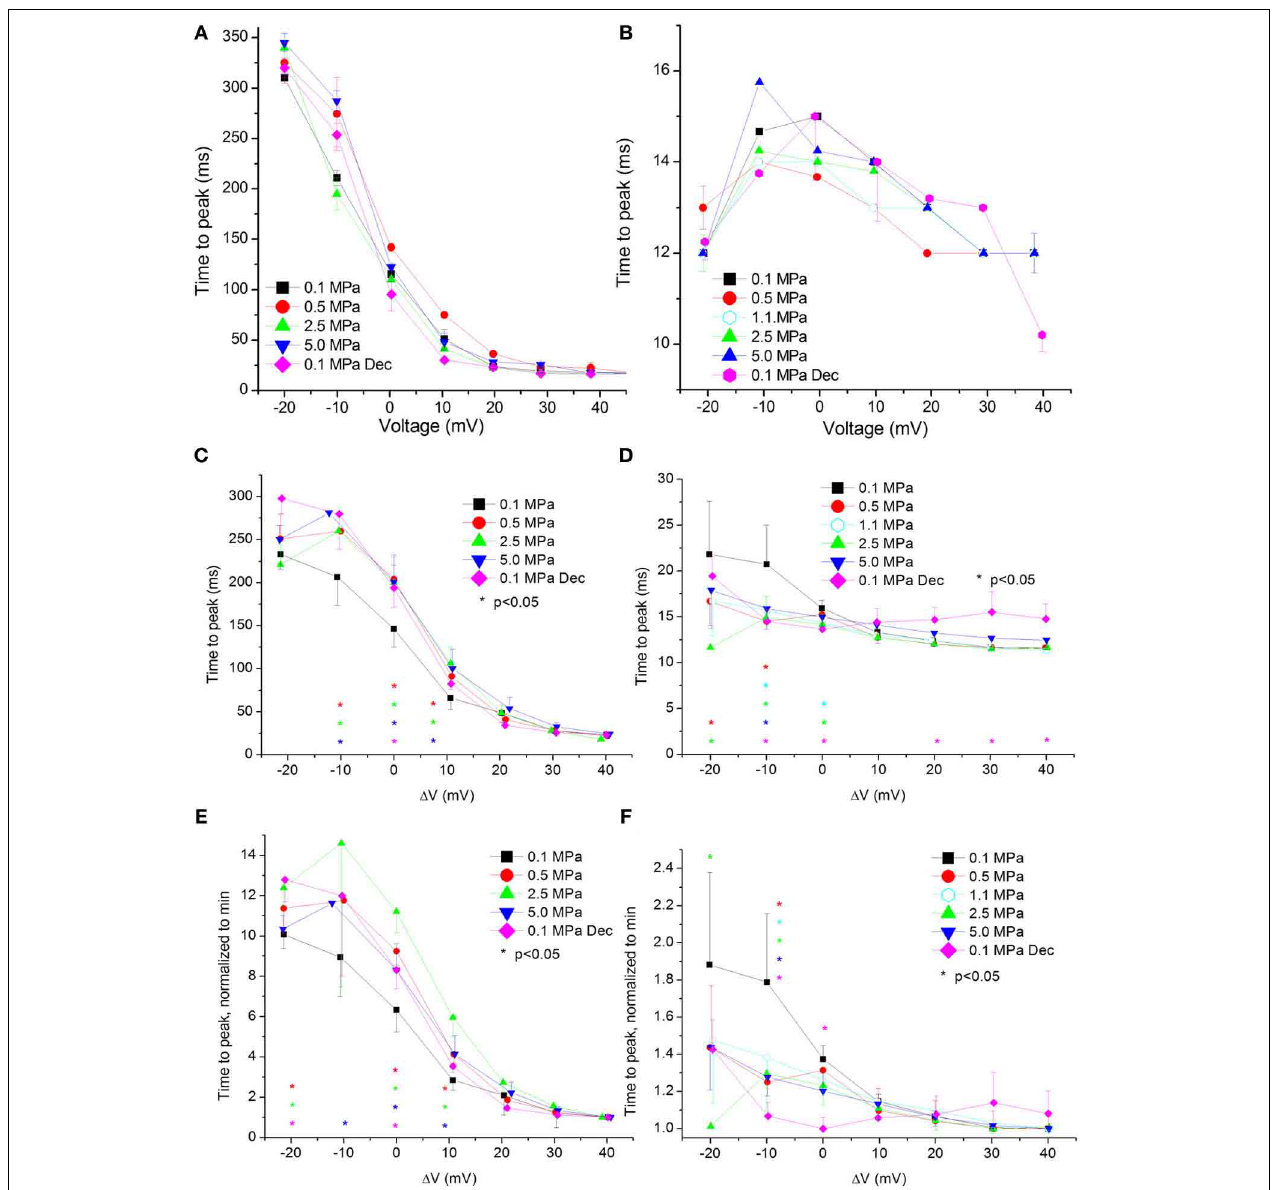
FIGURE 6 | Time to current peak (TTP, from stimulus onset) at various pressures. (A,C,E) in Ca V 1.2 and (B,D,F) in Ca V 3.2 channels. (A,B) TTP measured in a single oocyte. (C,D) Pooled data of the channels. (E,F) Normalized TTP: each curve is normalized to its own minimal value and